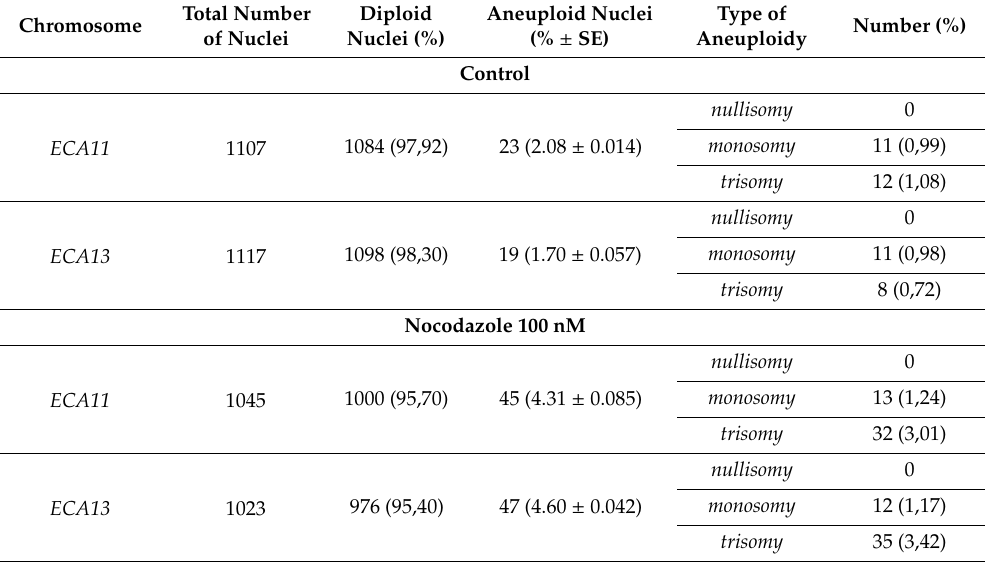
Table 2. Interphase FISH under mitotic